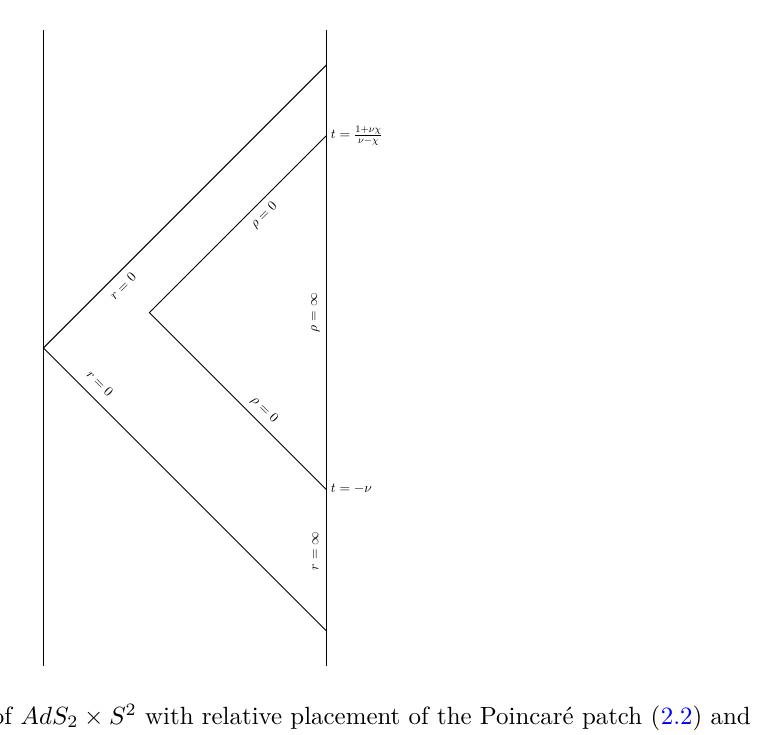
Figure 2 . Penrose diagram of AdS 2 × S 2 with relative placement of the Poincaré patch (2.2) and the Rindler patch (3.7) according to the transformation